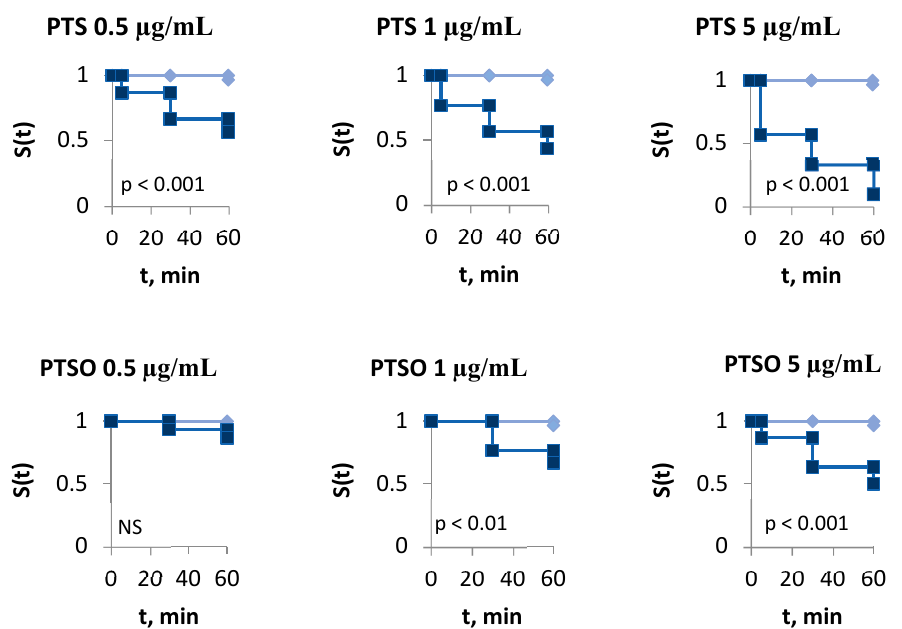
Figure 3. Kaplan–Meier survival curves for Sparicotyle chrysophrii larvae incubated at different concentrations of PTS and PTSO (0.5, 1 and 5 µg/mL each) at 0, 5, 30 and 60 min compared to control, using the long-rank test at a 95% confidence level. NS, not significant. ⧫: Control group; ■: treatment group.